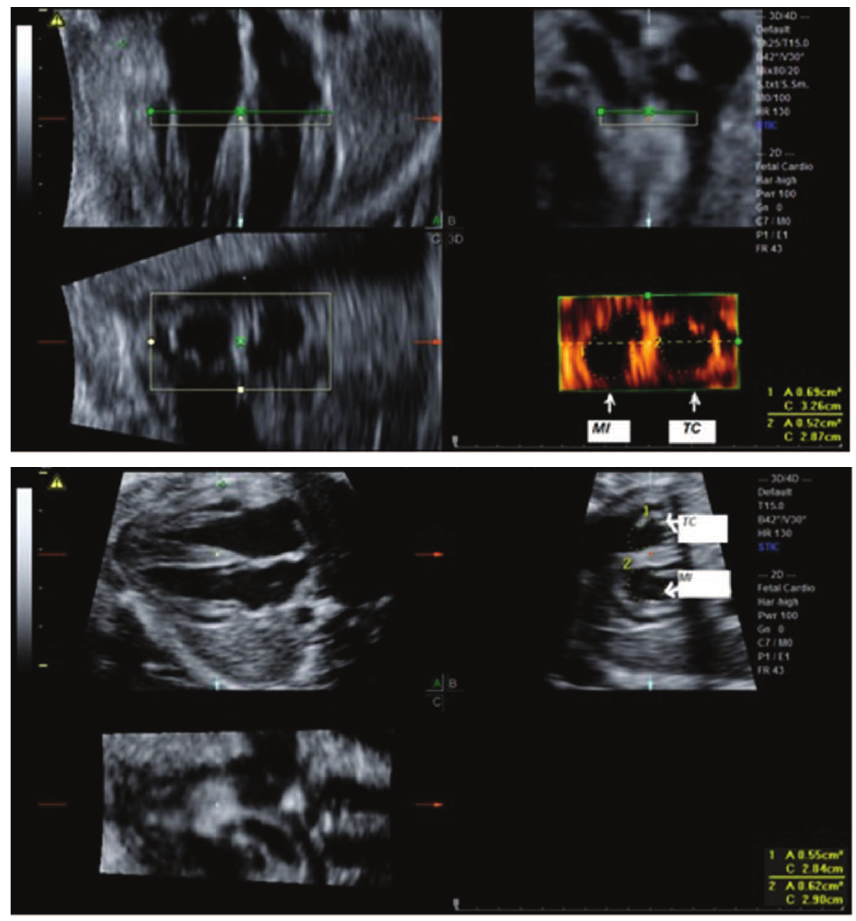
Fig. 1 - (A) Rendering image of atrioventricular valve at the initial moment of ventricular systole, with the extent of their respective areas performed manually. (B) Image by multiplanar method of atrioventricular valves in the sagittal plane at the time of initial ventricular diastole and the extent of their respective areas (MI: mitral, TC: